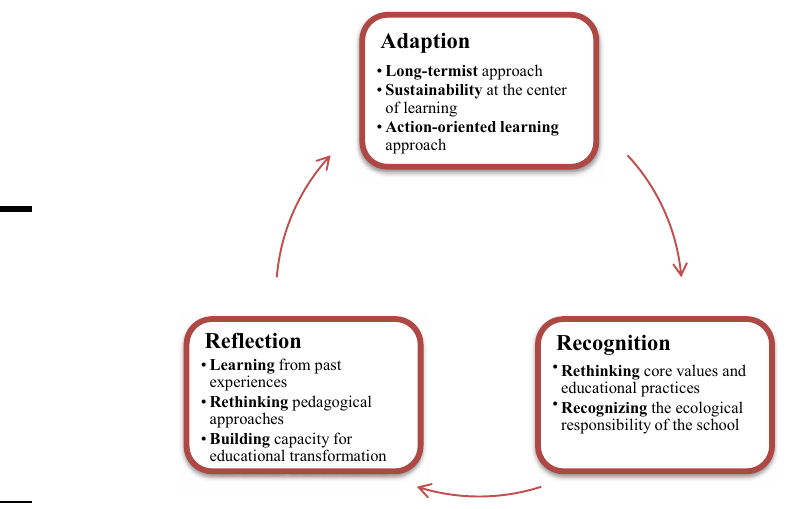
(cid:129) Building capacityfor educational transformation